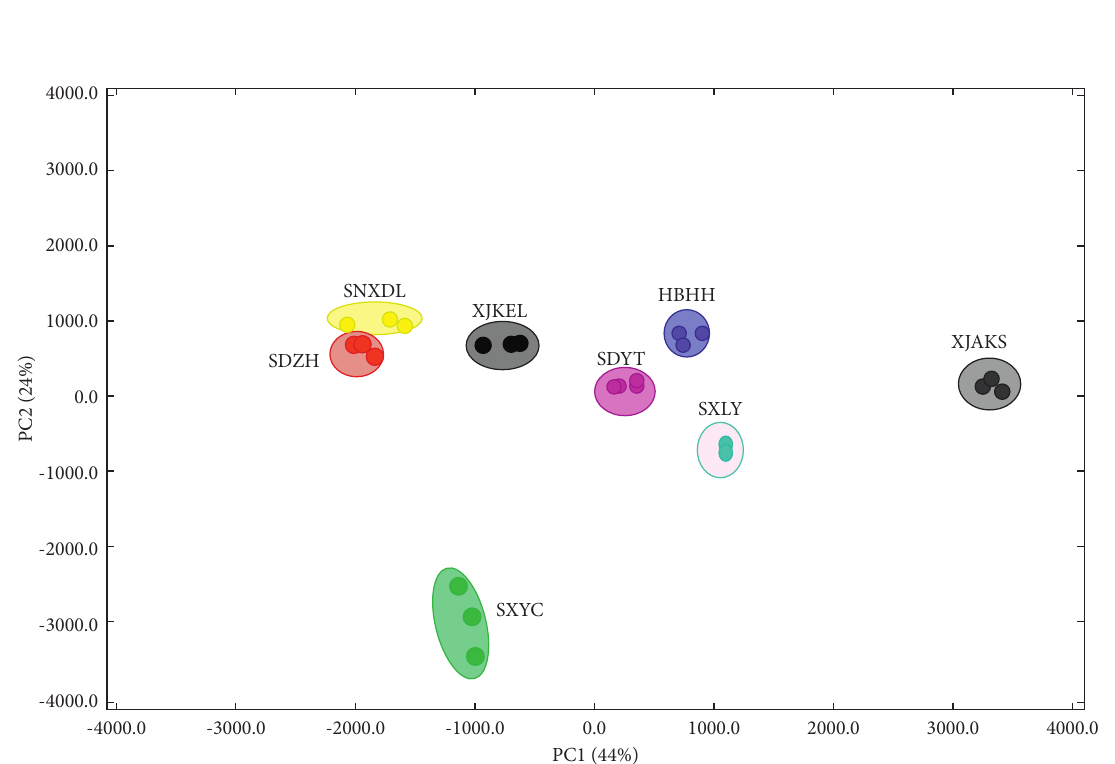
Figure 2: PCA plot of eight regions of winter